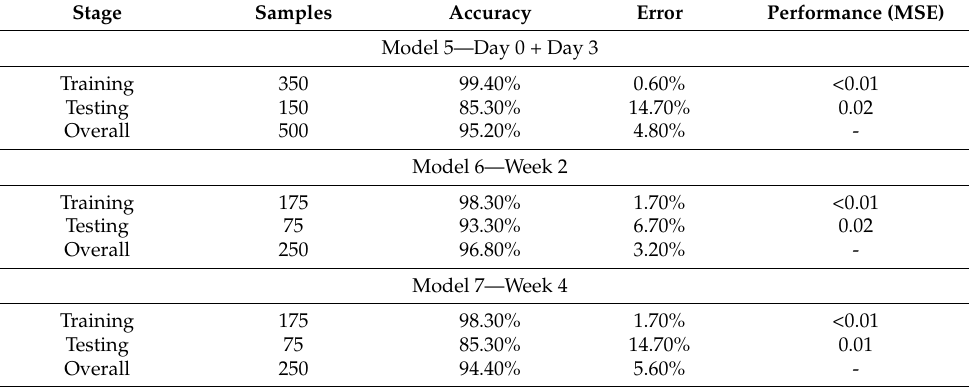
Table 3. Machine learning pattern recognition models based on artificial neural networks (Bayesian regularization) to classify tomato plants into different levels of pathogen inoculum using the electronic nose outputs as inputs. Abbreviations: MSE: means squared